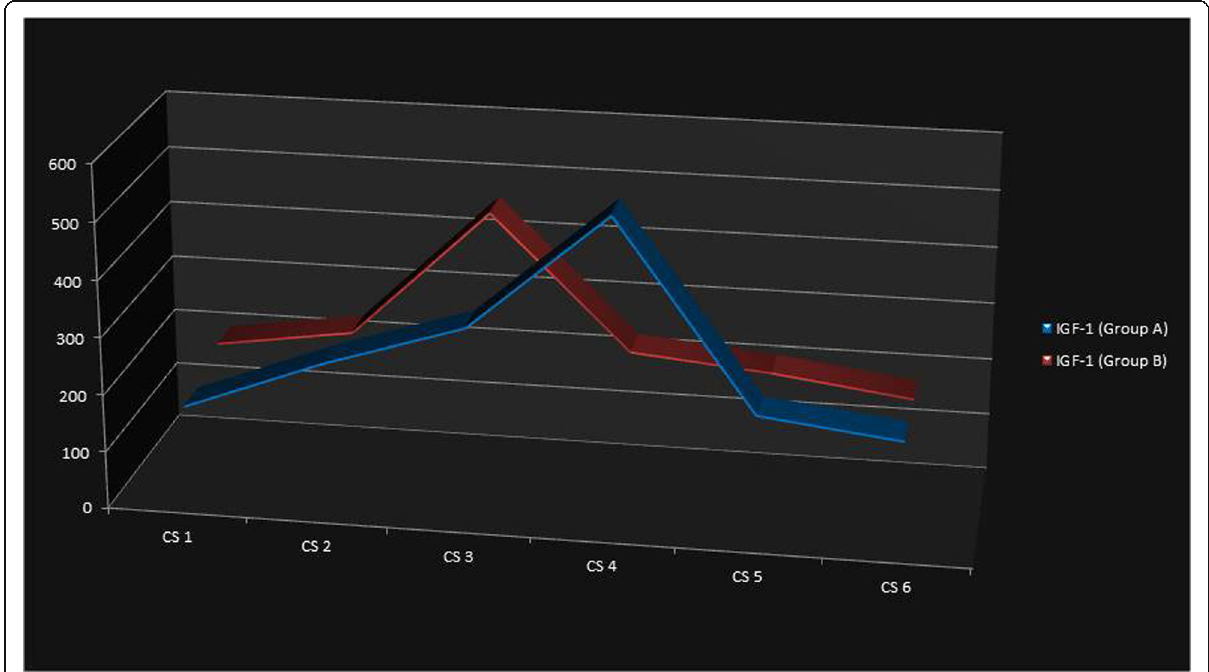
Fig. 1 Serum IGF-1 levels in each CS stage in group A and group B